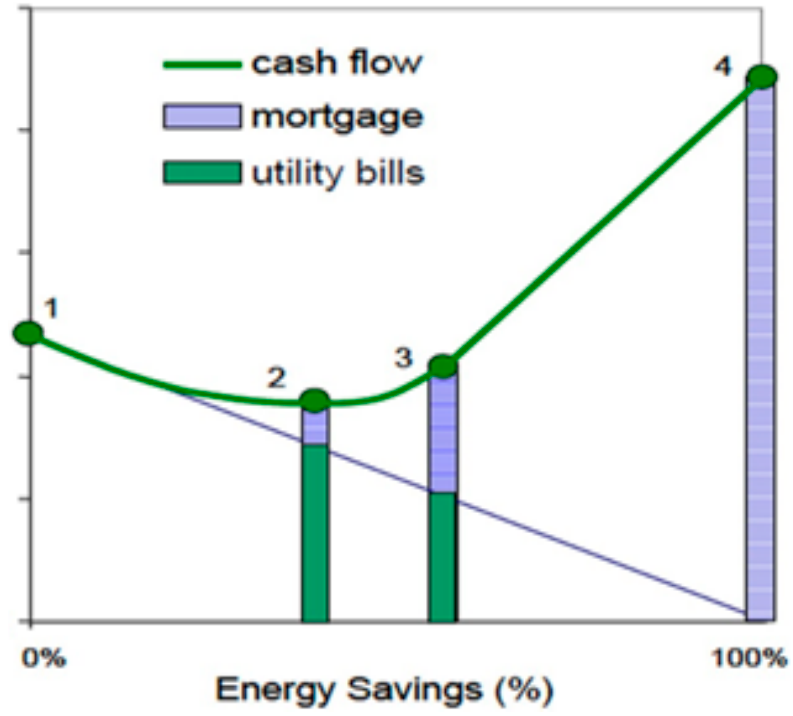
Figure 2. Costs of utilities (green) and mortgage (blue) versus energy savings from zero savings to 100% savings. Point 1 is the starting point, point 2 the energy conservation measures alone, and point 3 the beginning of PV contribution (from Wright & Klingenberg [36] with permission).